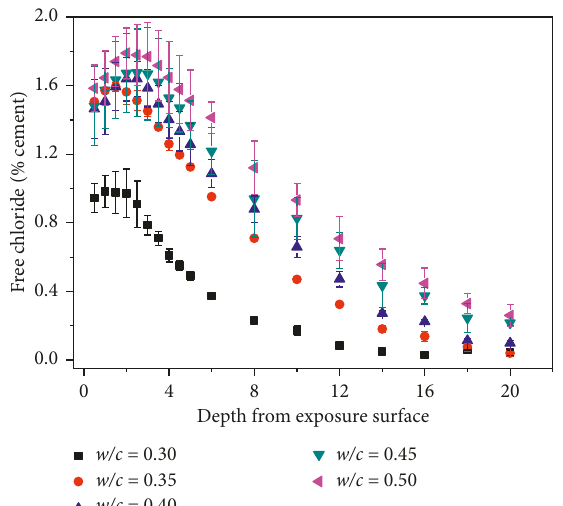
Figure 2: Free chloride profiles of paste specimens with different w / c .